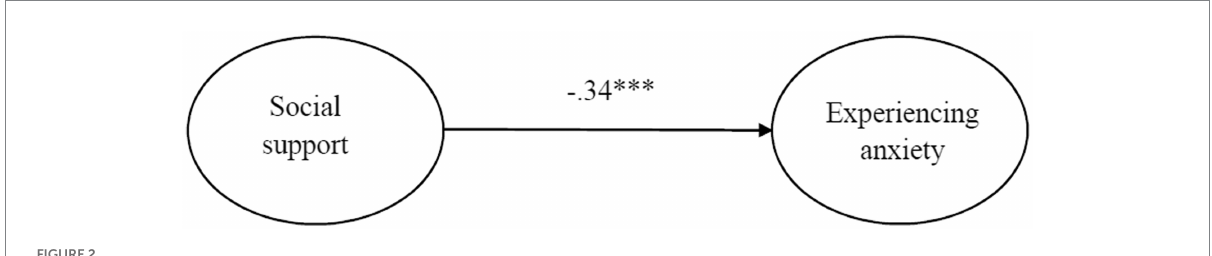
FIGURE 2 Main effect of social support to experiencing anxiety. *** p <